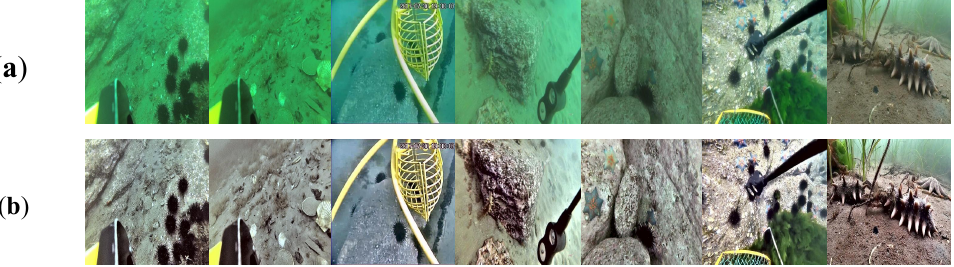
Figure 11. The underwater raw images and images produced by MLLE image enhancement. ( a ) shows the underwater images without any processing, while ( b ) shows the underwater images after image